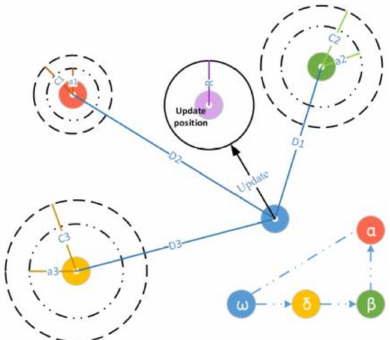
Figure 6. Updating process of wolves’ position in Grey Wolf Optimizer